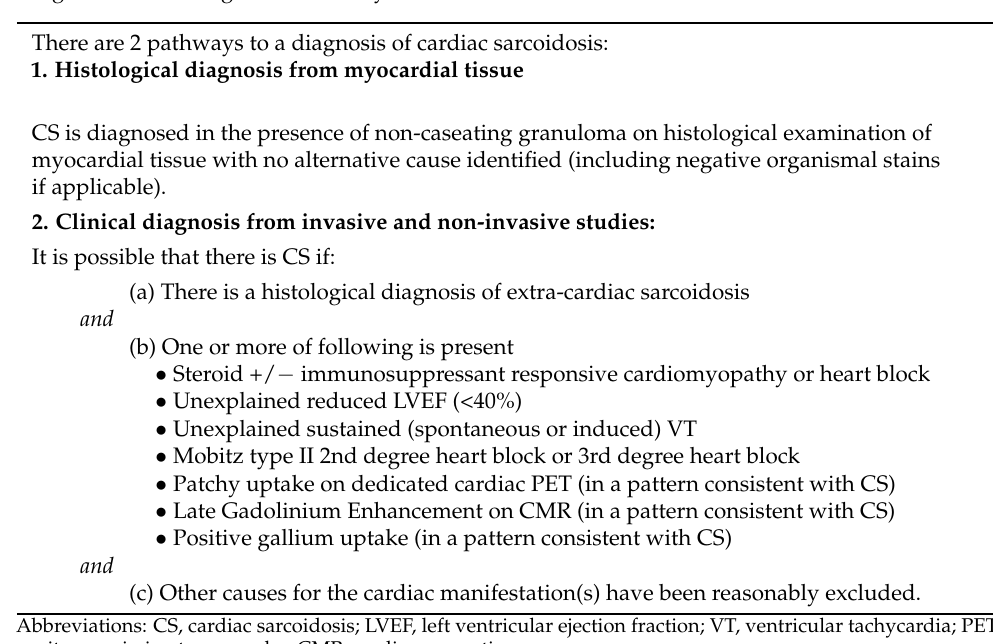
Table 1. Diagnostic criteria for 2014 Heart Rhythm Society Expert Consensus Statement on the Diagnosis and Management of Arrhythmias Associated with Cardiac Sarcoidosis.